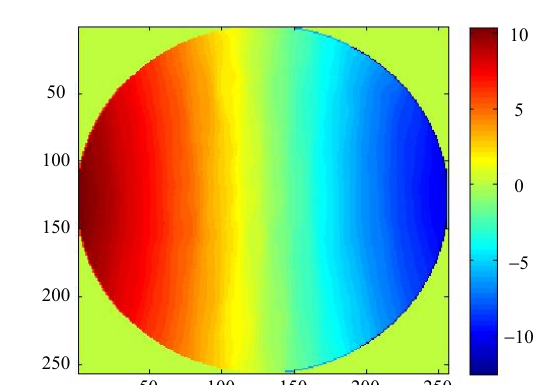
Fig. 9 RMS of the restoration phase with the calibration method.